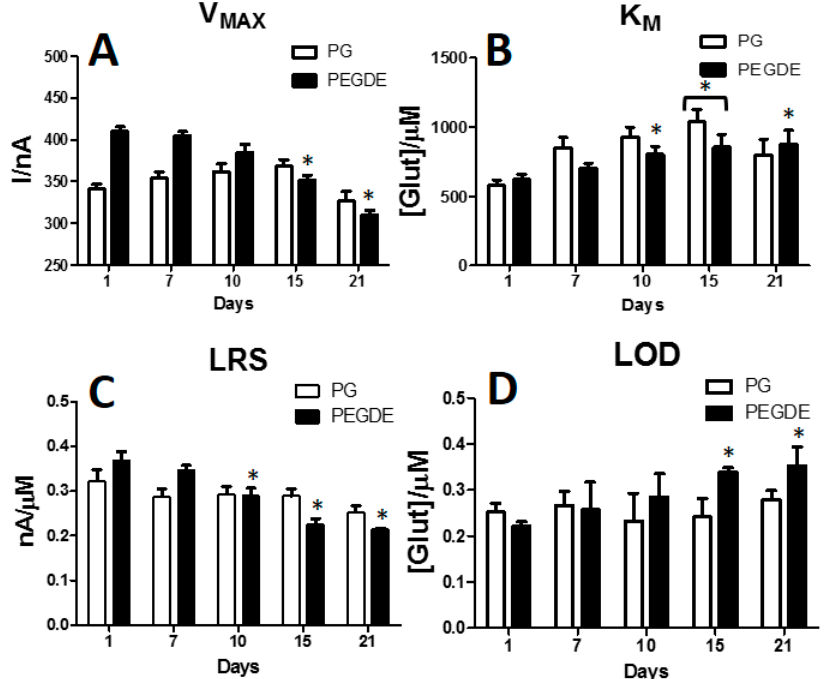
Figure 5. Bar chart describing the variations of V MAX (Panel A), K M (Panel B), LRS (Panel C) and LOD (Panel D) of the two selected design Pt c /PPD/PEI(1%) 2 /GlutOx 5 /PG(0.1%) (PG (0.1%)-white bars) and Pt c /PPD/PEI(1%) 2 /GlutOx 5 /PEGDE(0.1%) (PEGDE (0.1%) -black bars) in the selected range of 21 days. Values are expressed as mean ± SEM. *p<0.05 vs. Day 1.